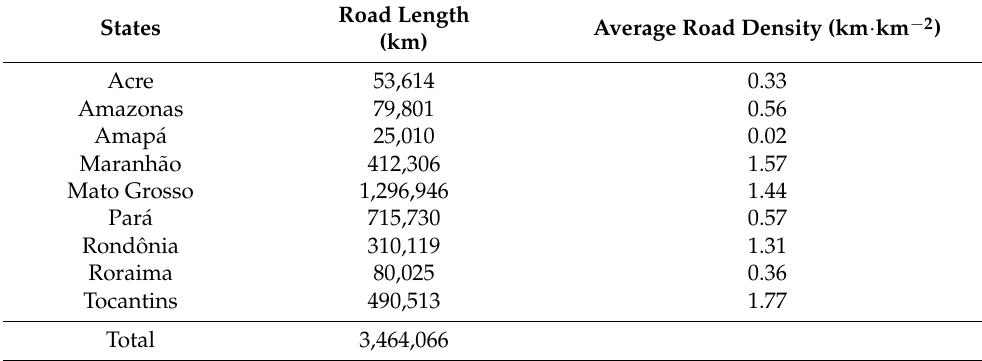
Table 1. Comparison between the length of roads detected per state in the Legal Amazon Area.